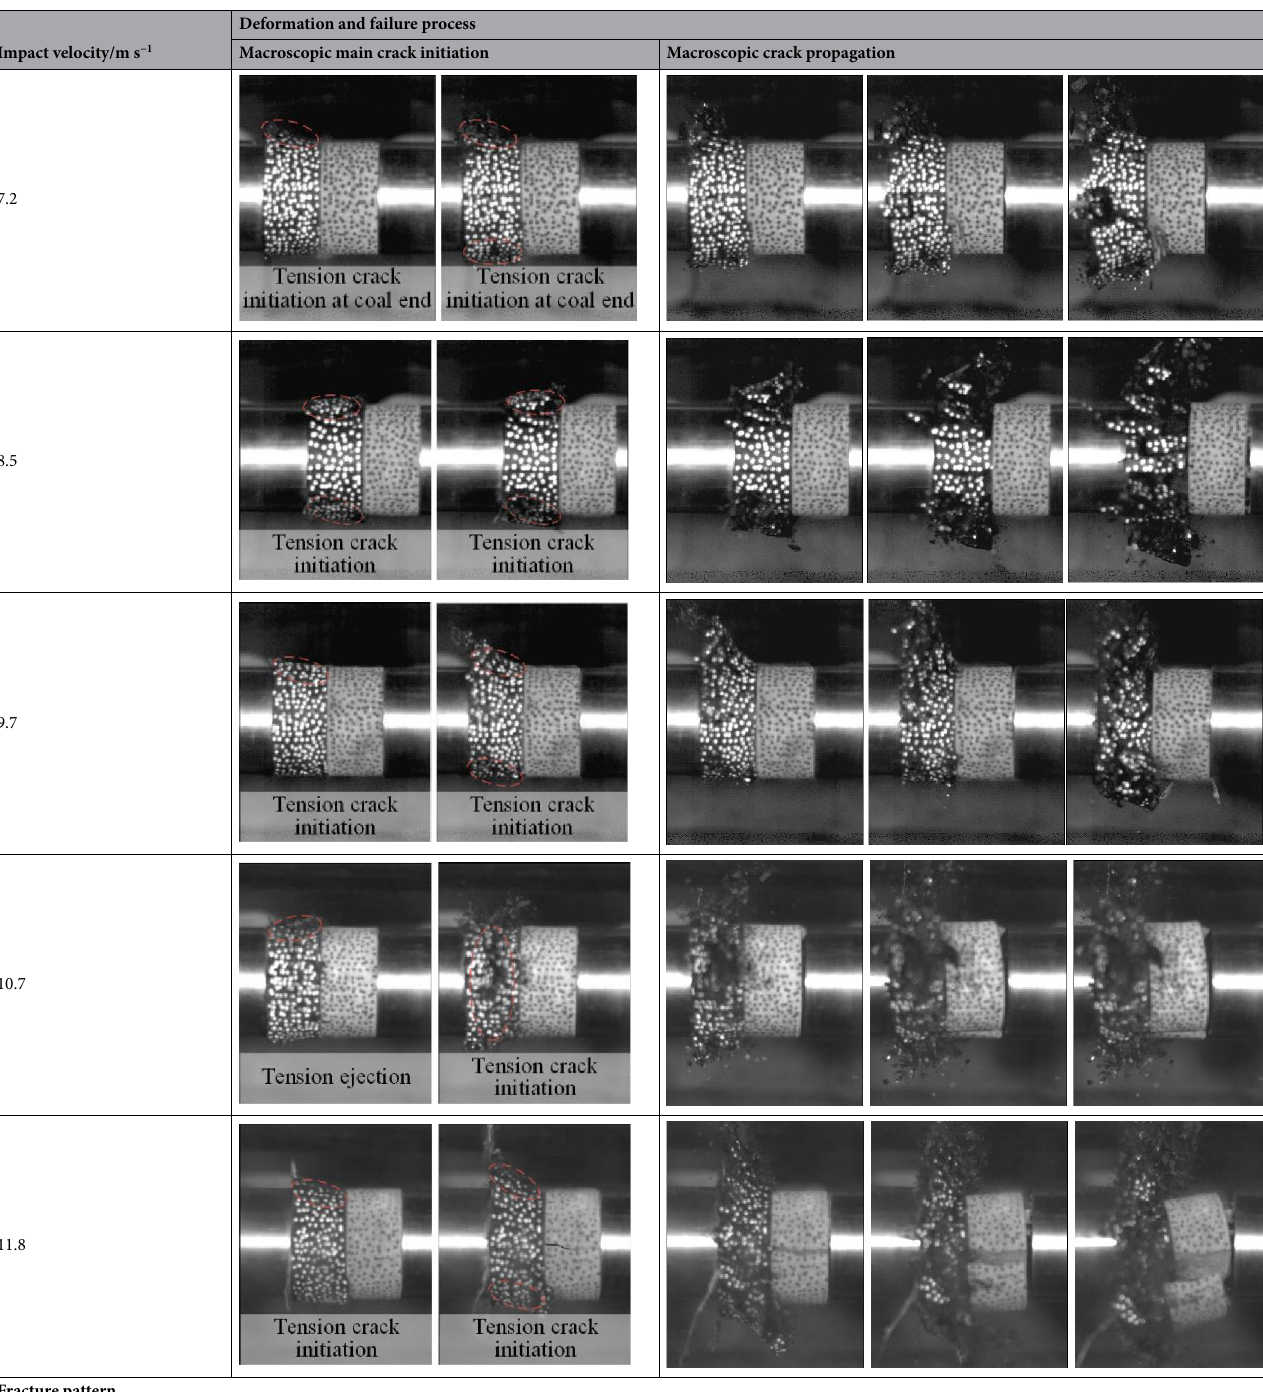
Table 3. Deformation and failure process of CRCB specimens. The green line represents coal cracks, and the black line represents rock